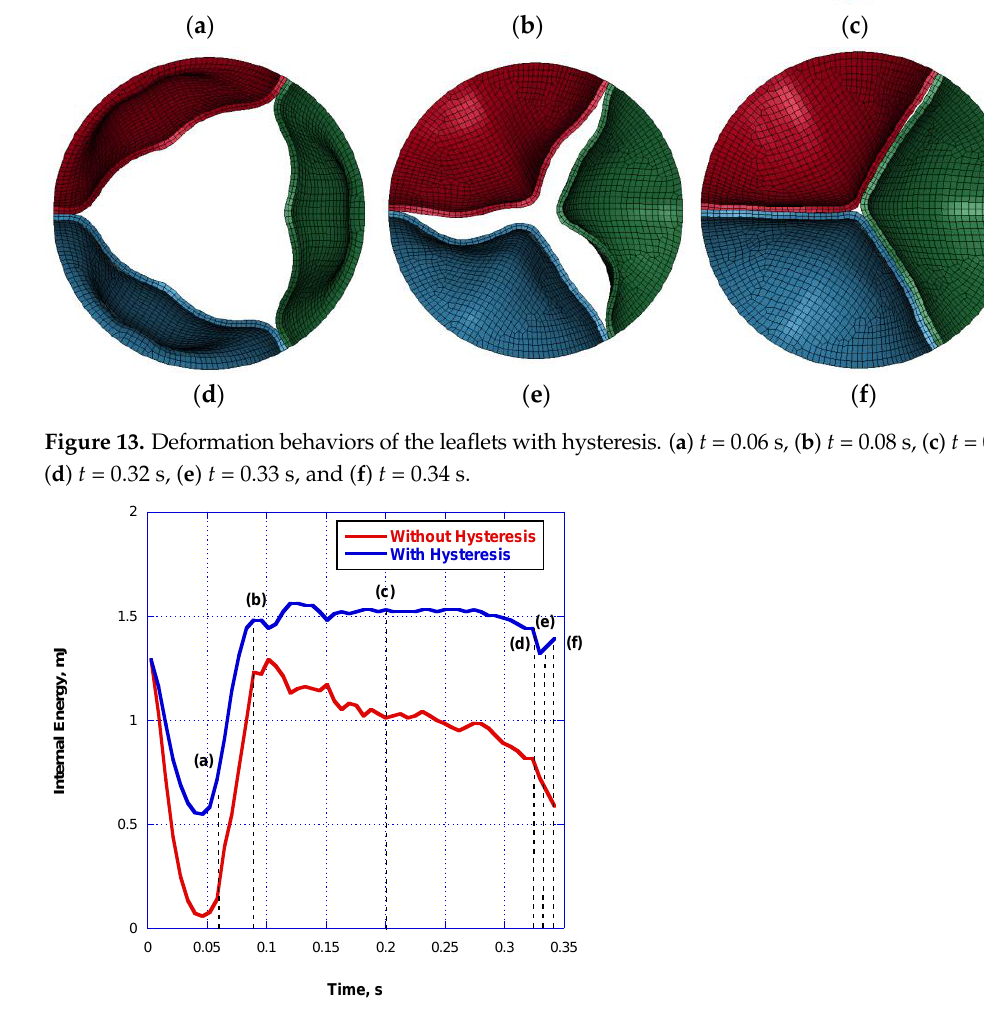
Figure 14. The stored energy of the leaflet with hysteresis and without hysteresis vs. time. The time variations of displacement were also evaluated at the three points A,